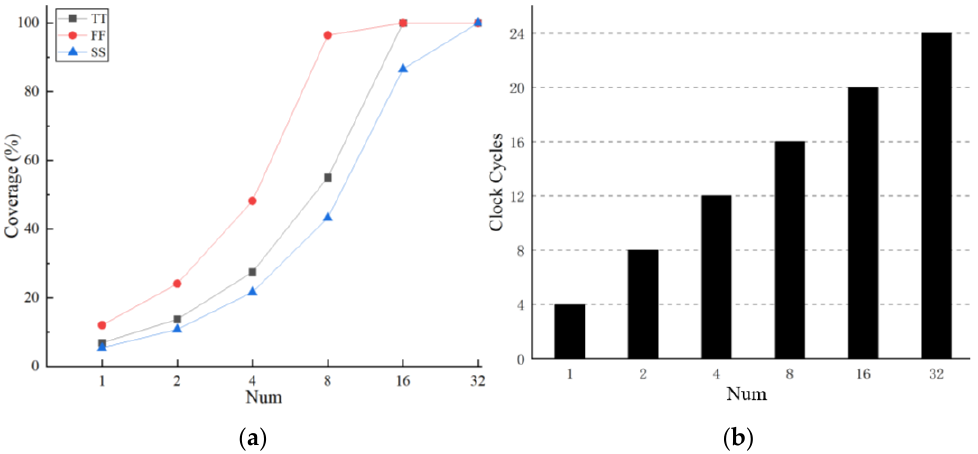
Figure 13. ( a ) Coverage of the delay change; ( b ) Clock cycles required for searching in tracking mode.